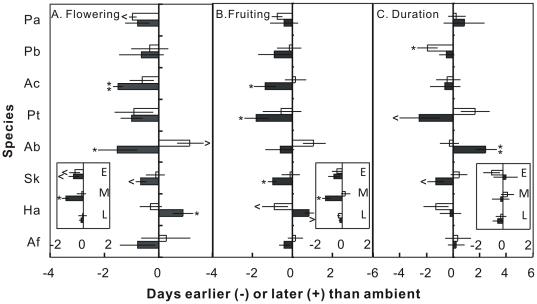
Changes in the flowering time (A), fruiting time (B), and reproductive duration (C) (in days) under day (open bars) and night (filled bars) warming.∧, P<0.10; *, P<0.05, **, P<0.05. See Fig. 2 for species name abbreviations.